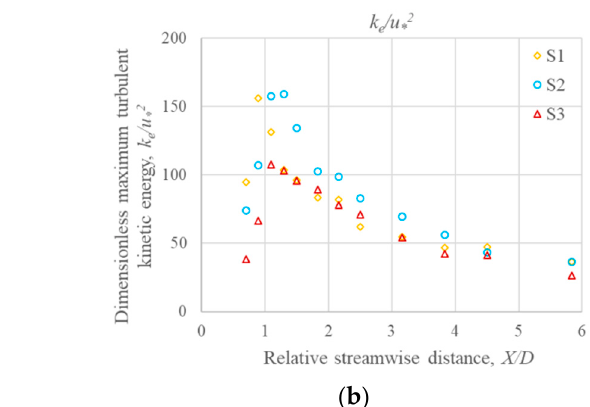
( b ) Figure 8. Variation of dimensionless maximum projected Reynolds shear stress ( τ p /u * 2 ) in the symmetry plane: ( a ) mid- stream and ( b ) downstream. 3.3. Near-Bed Shear Stress The spatial distribution of the dimensionless maximum near-bed shear stress ( 𝜏 (cid:3029)∗ ) is of great importance in the presence of cylinders that significantly change the local flow